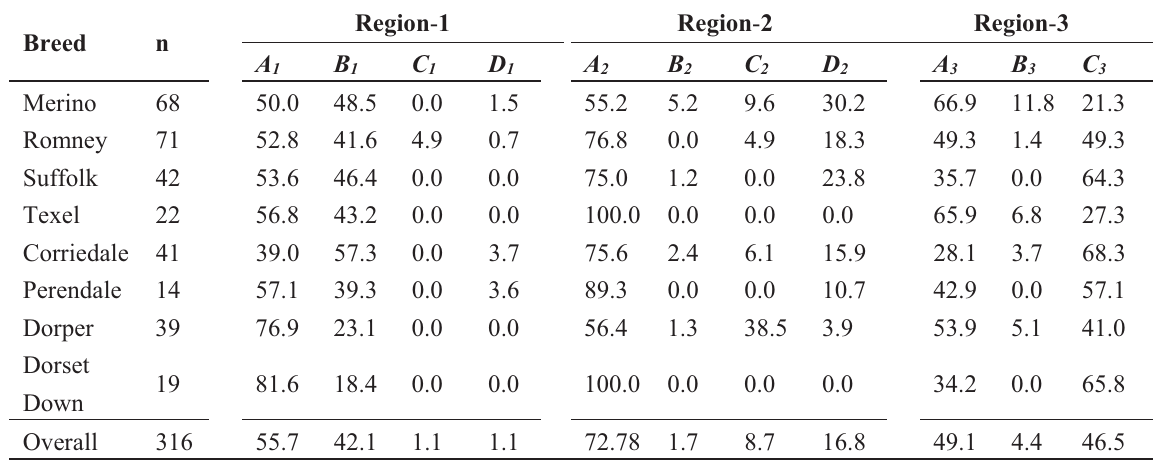
Dorper Dorset Down Overall 316